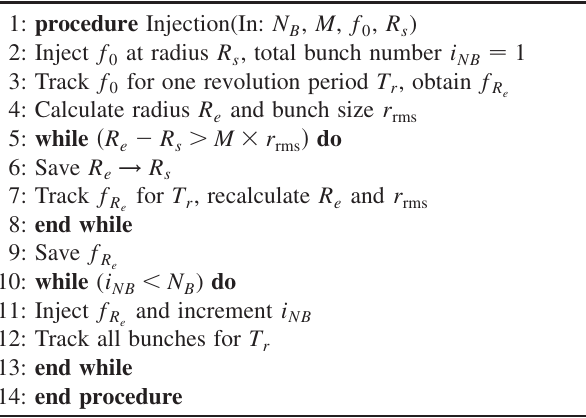
scale.Algorithm 2. Multibunch injection